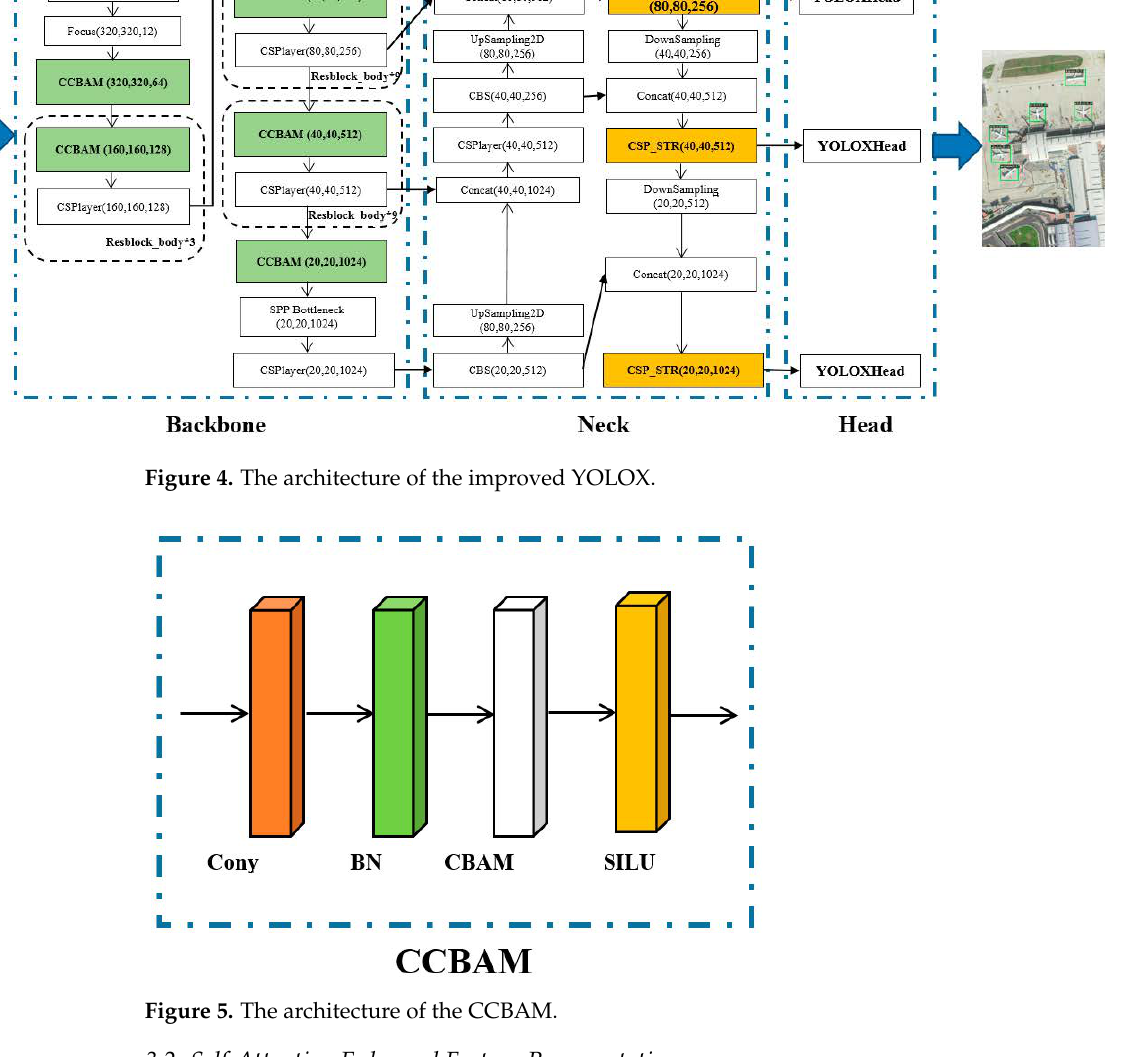
Figure 4. The architecture of the improved YOLOX.